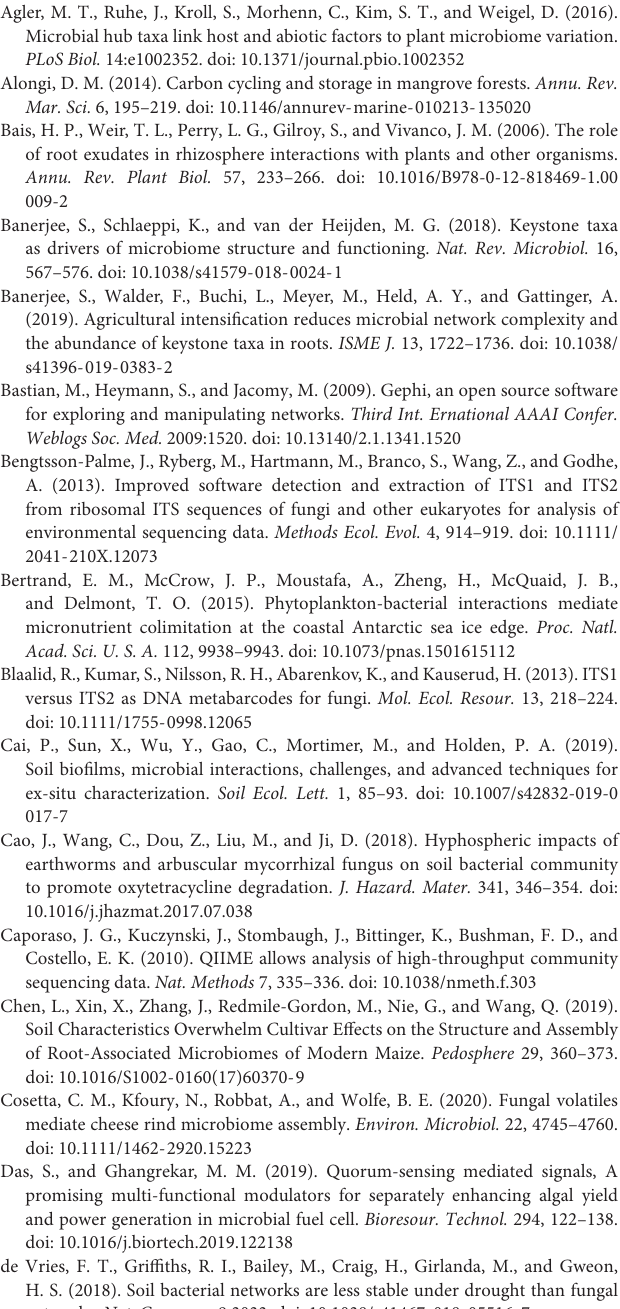
Supplementary Table 4 | Key network topological characteristics for bacterial, fungal and bacterial-fungal association (BFA) networks across the